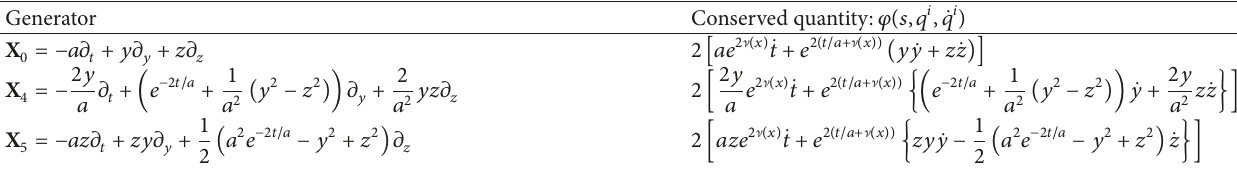
Table 35: Conserved quantities corresponding to each Noether symmetry.